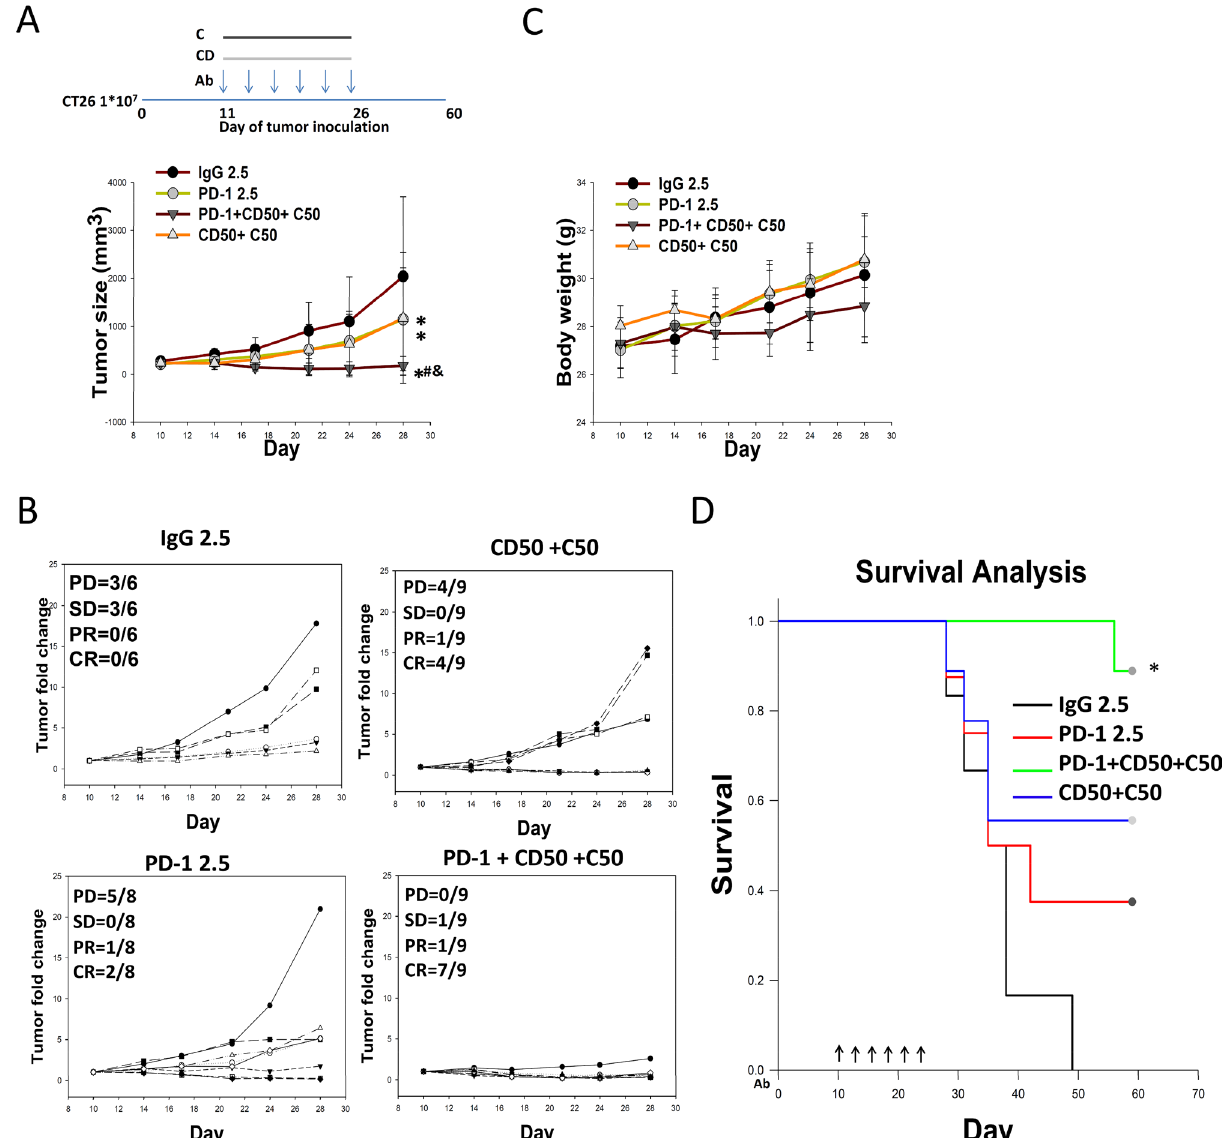
Figure 2. Chidamide + celecoxib suppress tumor growth and enhance anti-PD-1-induced immunotherapy in an allograft CT26 mouse model. ( A ) CT26 tumor-bearing mice were orally administered a chidamide-k30 solution (CD, 50 mg/kg) once daily from days 10 to 25 (Day 10 mean TV, 240 ± 25 mm 3 ), and celecoxib (C, 50 mg/kg) once daily from days 10 to 25. Arrows indicate the time points at which mice were treated with the anti-PD-1 antibody. The mice were treated with anti-PD-1 antibody (2.5 mg/kg, i.p.) once every 3 days on days 10, 13, 16, 19, 22, and 25. Endpoint tumor size is presented as fold change. Results are shown as mean ± standard deviation (SD). *p < 0.05 vs. anti-IgG; # p < 0.05 vs. anti-PD-1; & p < 0.05 vs. CD50 + C50. ( B ) Individual tumor growth graphs for CT26 tumor-bearing mice (n = 6–9). Number of tumor-free mice per total number of mice is shown at the top left corner of each panel. ( C ) Body weight of mice following each treatment was recorded. ( D ) Survival study of all the treatment the absence of tumor-killing T cells in nude mice (Fig. 3C,D). The efficacy results of individual mice are shown in Fig. 3F for immunodeficient mice and Fig. 3G for immunocompetent mice. To exclude the cytotoxicity effect of chidamide and celecoxib, we performed in vitro cell model to clarify this issue. The results showed that sup- pressed tumor proliferation, necessitating approximately 10 μM in both M10 and CT26 but > 10 μM in M231 (SFig. 4C). These results suggested that combining chidamide and celecoxib may activate immune cells such as CTL/NK cells in the TME to reduce the tumor burden. To evaluate whether the antitumor activity of the triple combination regimen was dependent on CD4 + or CD8 + T cell activation, we compared the antitumor activity of triple combination regimen with and without the presence of CD4 + or CD8 + T cells in the CT26 mouse model by using an anti-CD4 or anti-CD8 antibody administered in wild type mice. We used flow cytometry to confirm that CD4 + T cell percentage was decreased